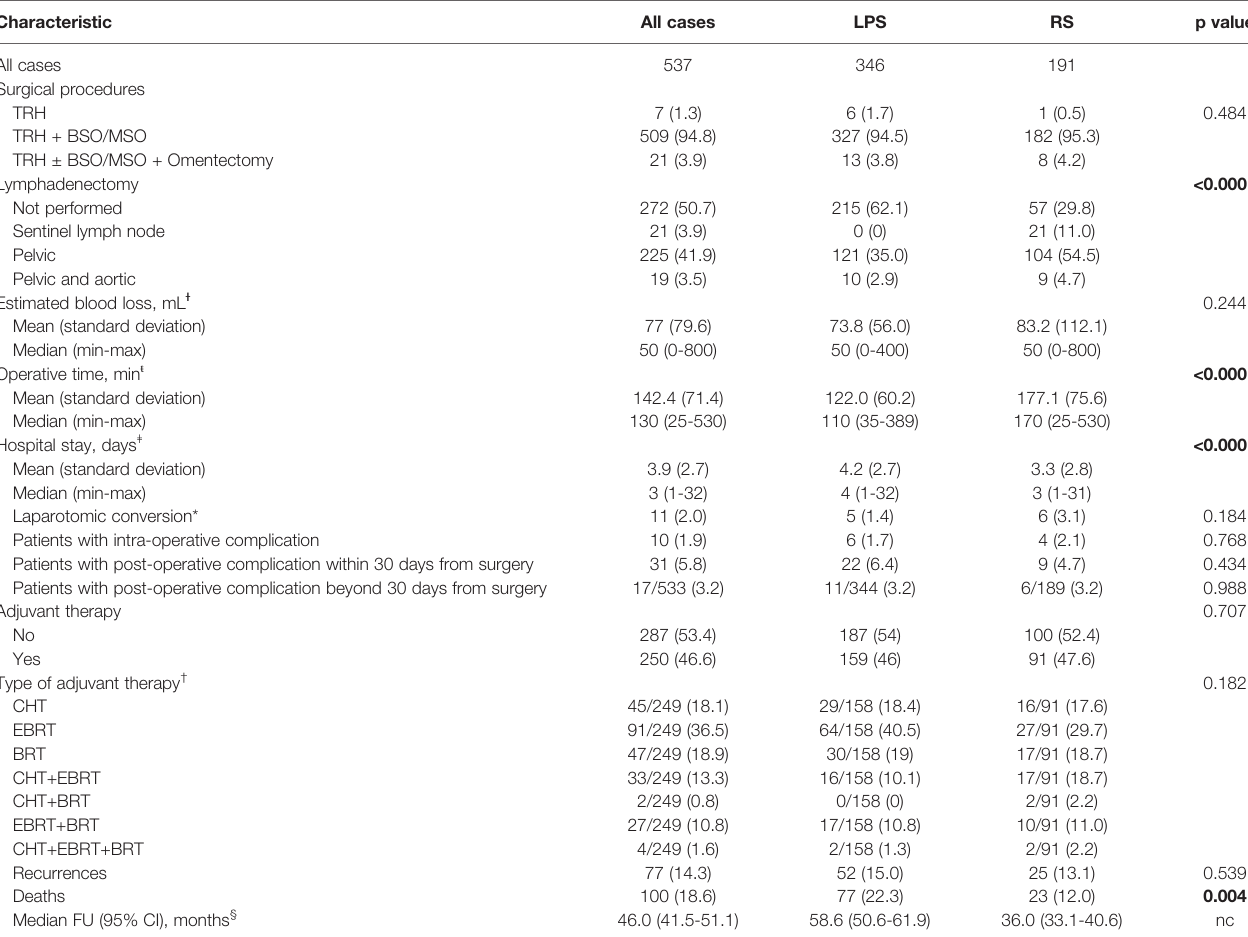
TABLE 2 | Surgical, adjuvant and follow up characteristics of 537 patients with endometrial cancer according to the type of surgery. Characteristic All